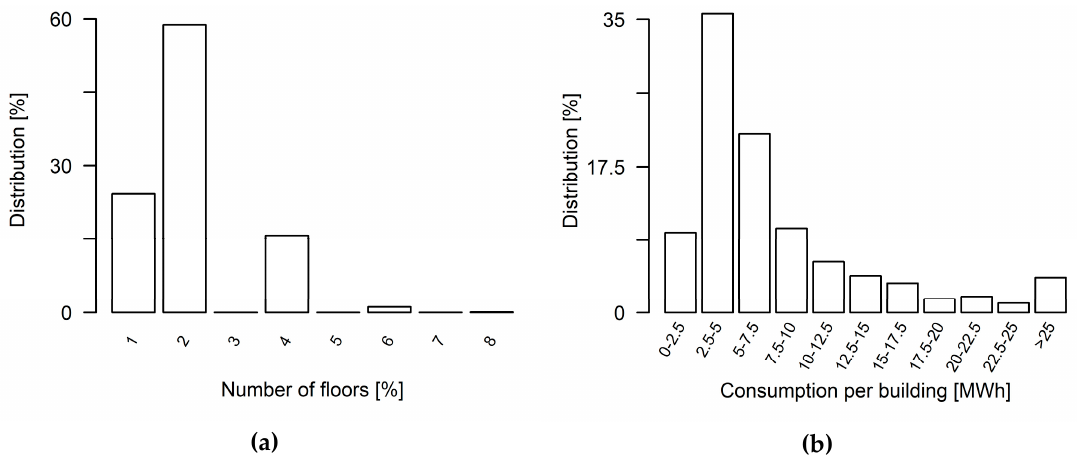
Figure 2. ( a ) Distribution of floor numbers used for the estimation of the living areas; ( b ) distribution of the average consumption rates per